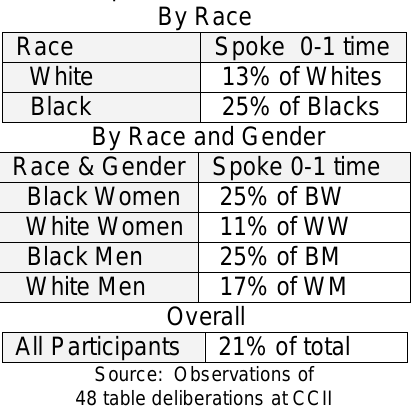
Who Spoke the Least at CCII? By Race Race Spoke 0-1 time White 13% of Whites Black 25% of Blacks By Race and Gender Race & Gender Spoke 0-1 time Black Women 25% of BW White Women 11% of WW Black Men 25% of BM White Men 17% of WM Overall All Participants 21% of total Source: Observations of 48 table deliberations at CCII